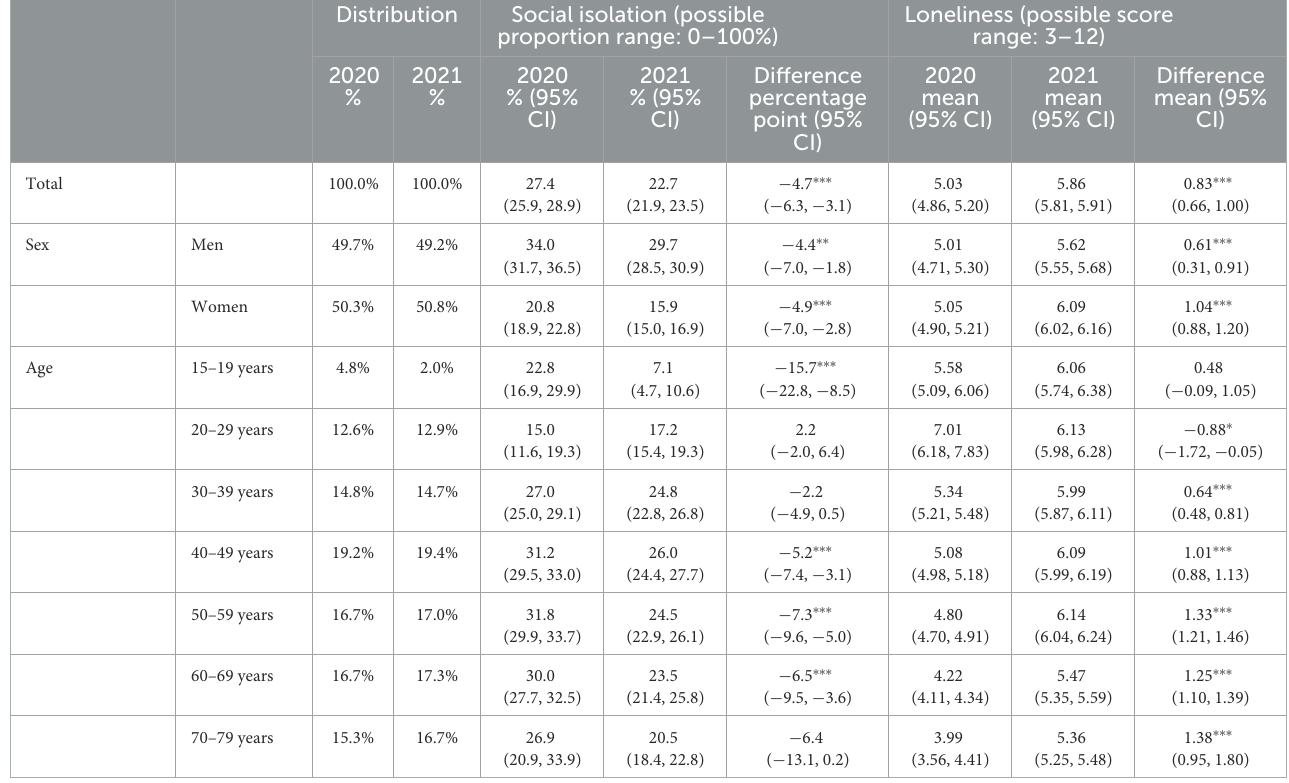
TABLE 1 The weighted prevalence of social isolation and loneliness by sex and age. Distribution Social isolation (possible proportion range: 0–100%)